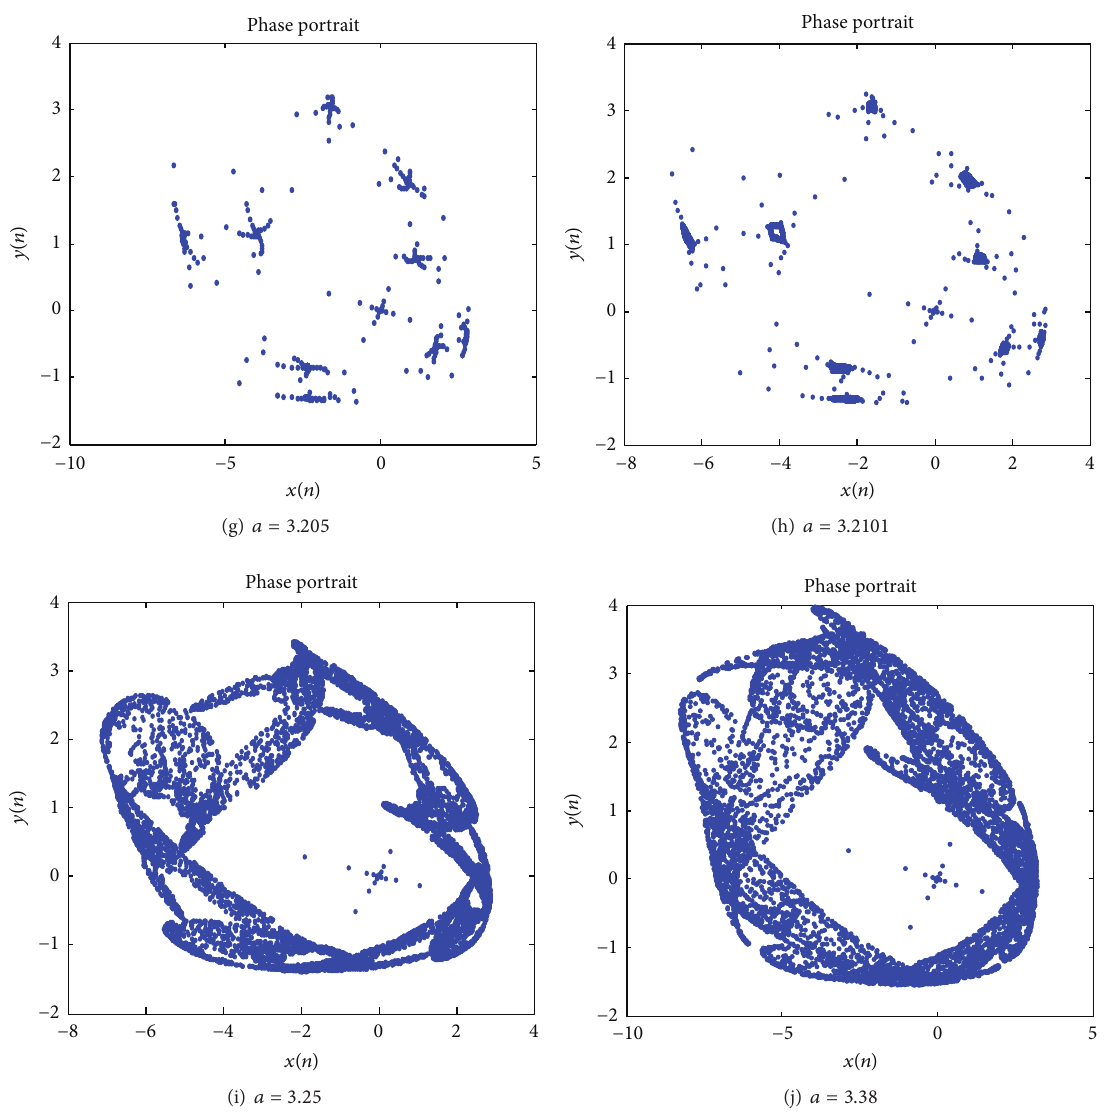
Figure 2: Phase portraits of system (1) when parameter 𝑎 changes in the range as shown in Figure 1(a). The initial values of system (1) are 𝑥(1) = 0.01 and 𝑦(1) = 0.01 .